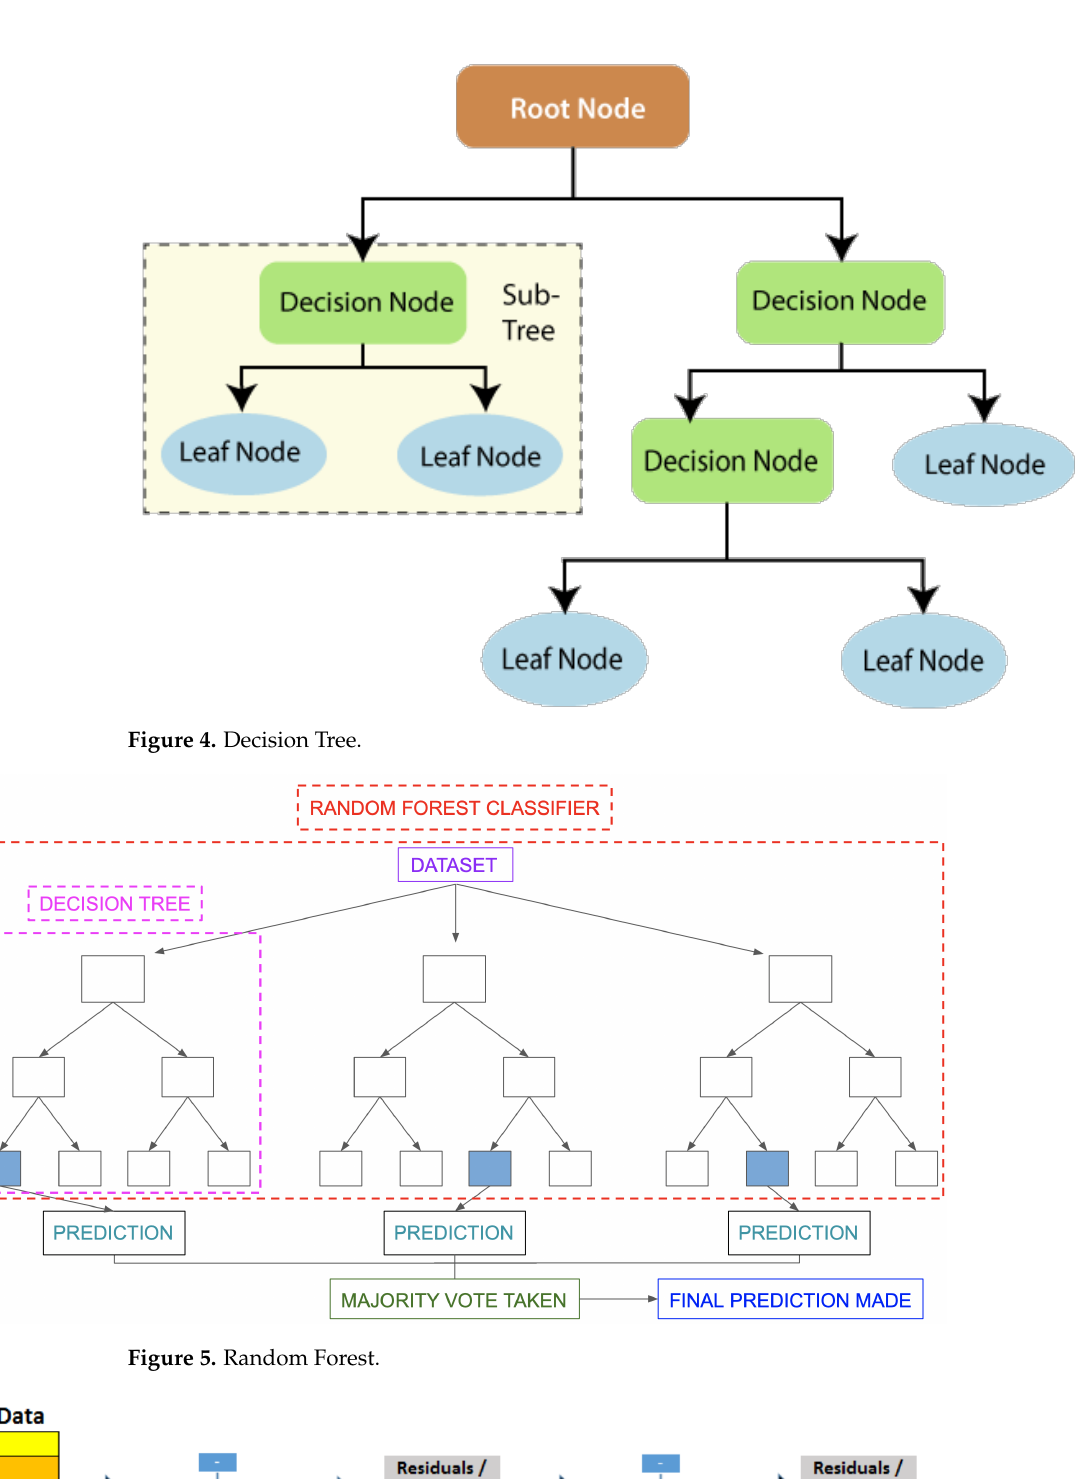
Figure 5. Random Forest.